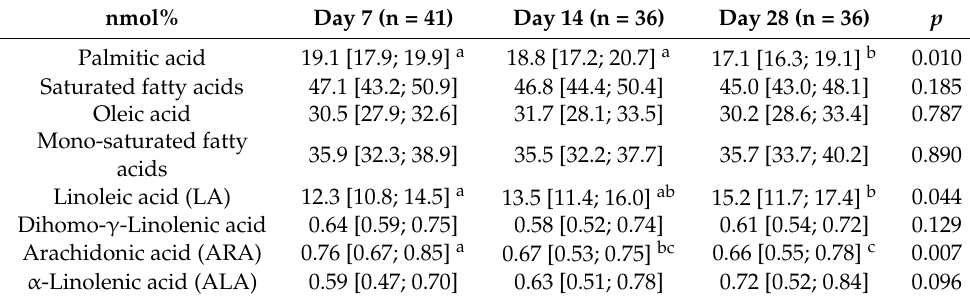
Table 1. Breast milk fatty acids at days 7, 14, and 28 of